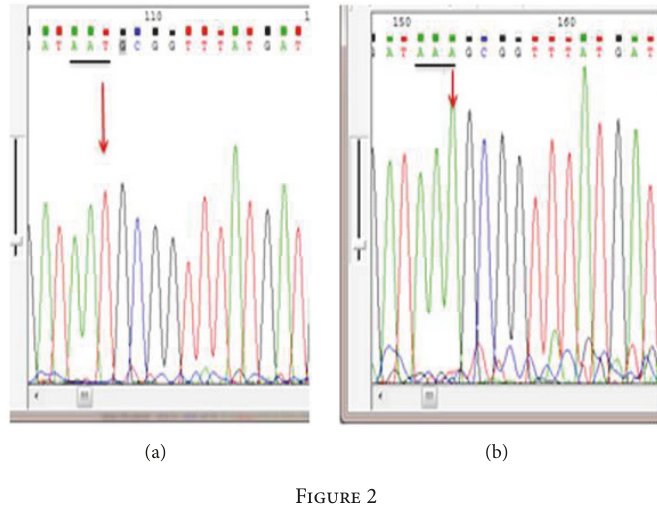
Homozygote Heterozygote H. All point H. pylori mutations identified